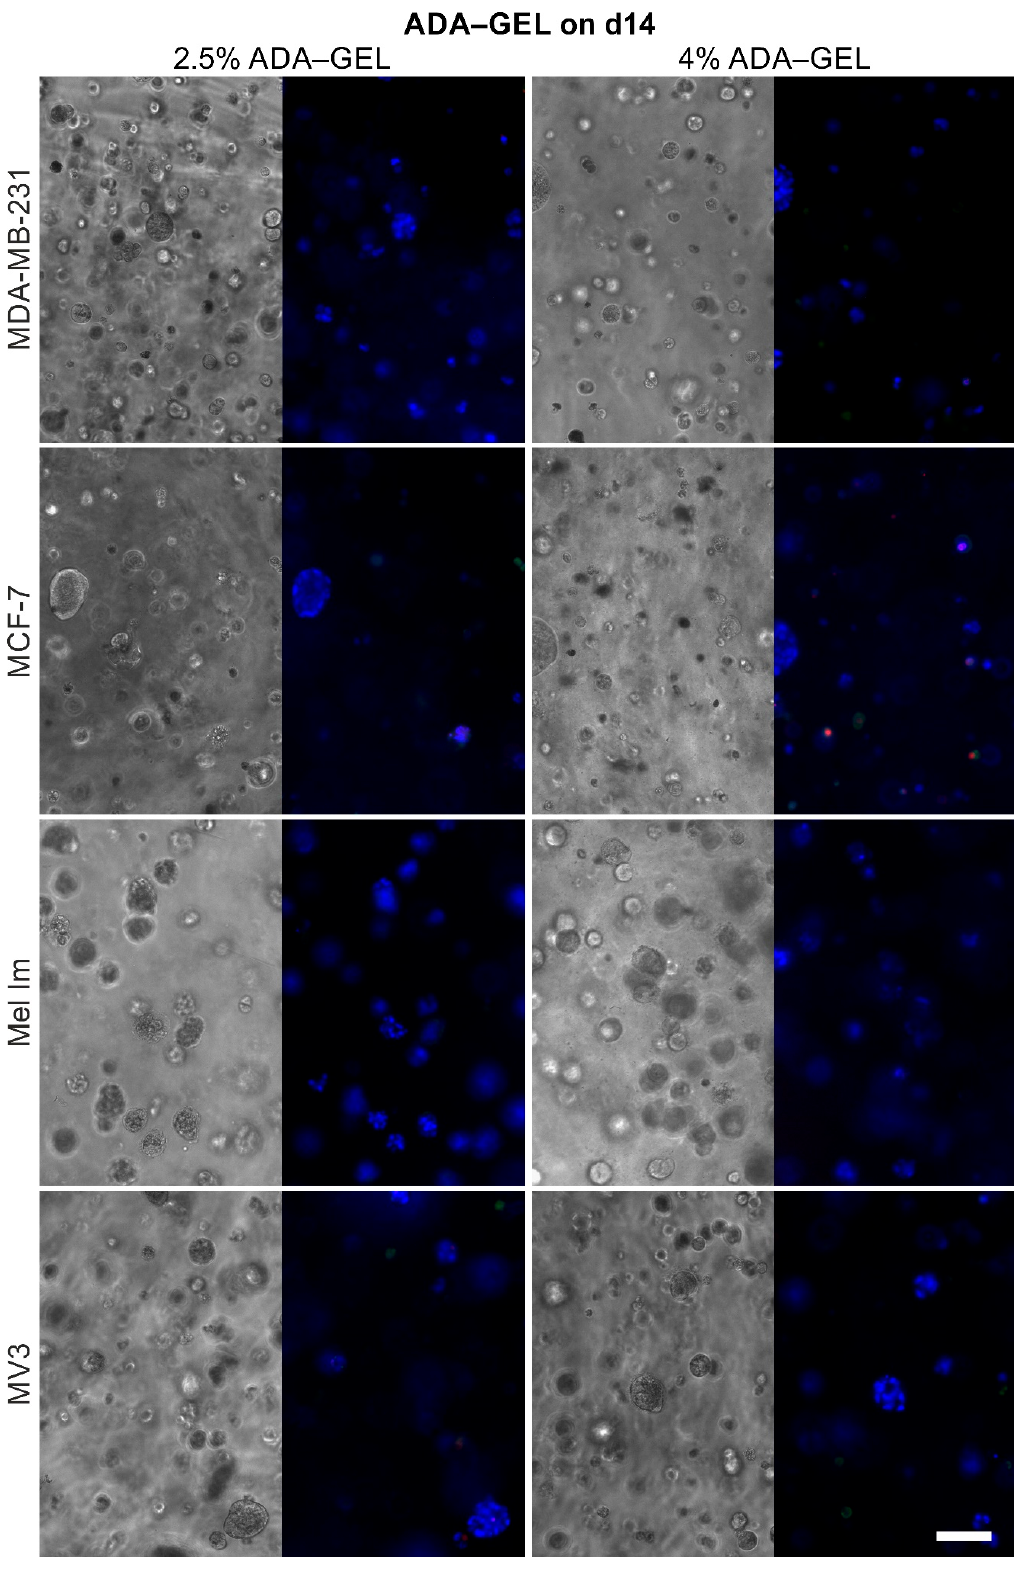
Figure 5. Representative phase contrast and fluorescence pictures of the cell survival and colony formation in ADA–GEL on day 14; adjacent pictures show the same position; blue = nucleic acid stain, green = apoptosis, and red = necrosis; scale bar = 100 µm.